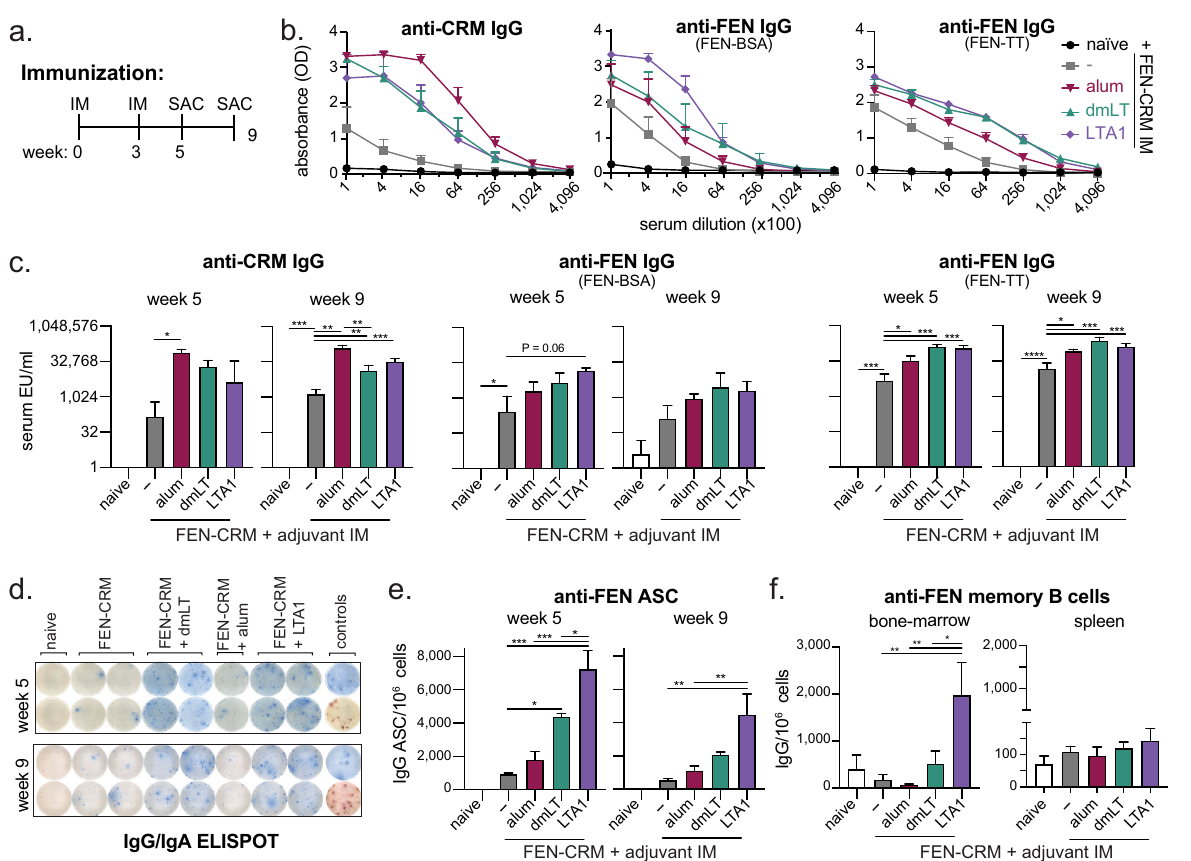
Fig. 2 Immune responses to prime/boost intramuscular immunization with FEN-CRM 197 are enhanced in magnitude and longevity with dmLT and LTA1 adjuvants. Groups of Balb/c mice ( n = 3 – 5) were left naïve or immunized IM with 5 μ g FEN-CRM ± 150 μ g alum, 0.1 μ g dmLT, or 5 μ g LTA1 on weeks 0 and 3. Two-weeks later (week 5) or six-weeks later (week 9) serum, spleen, and bone-marrow was collected for antibody evaluations. a Schematic of the immunization schedule. b Raw ELISA data for week 5 serum anti-CRM or anti-FEN serum IgG expressed as absorbance. Two anti-FEN ELISA coating antigens were used as indicated by FEN-BSA or FEN-TT. c Compiled week 5 and 9 serum anti-CRM or anti-FEN (coating antigen indicated) serum IgG. d Representative anti-FEN (FEN-TT coating antigen) IgG/IgA ELISPOT images from bone-marrow of week 5 immunized mice. Blue spots indicate IgG and red spots IgA ASCs. e Compiled anti-FEN IgG ASC per 1e6 cells from bone marrow. f Anti-FEN IgG memory B cells per 10 6 cells differentiated in culture from immunized splenocytes from week 9 post immunization. Bars at mean + s.e.m. with signi fi cance determined by ANOVA paired with Bonferroni post-hoc test as shown (* P < 0.05, ** P < 0.01, *** P <